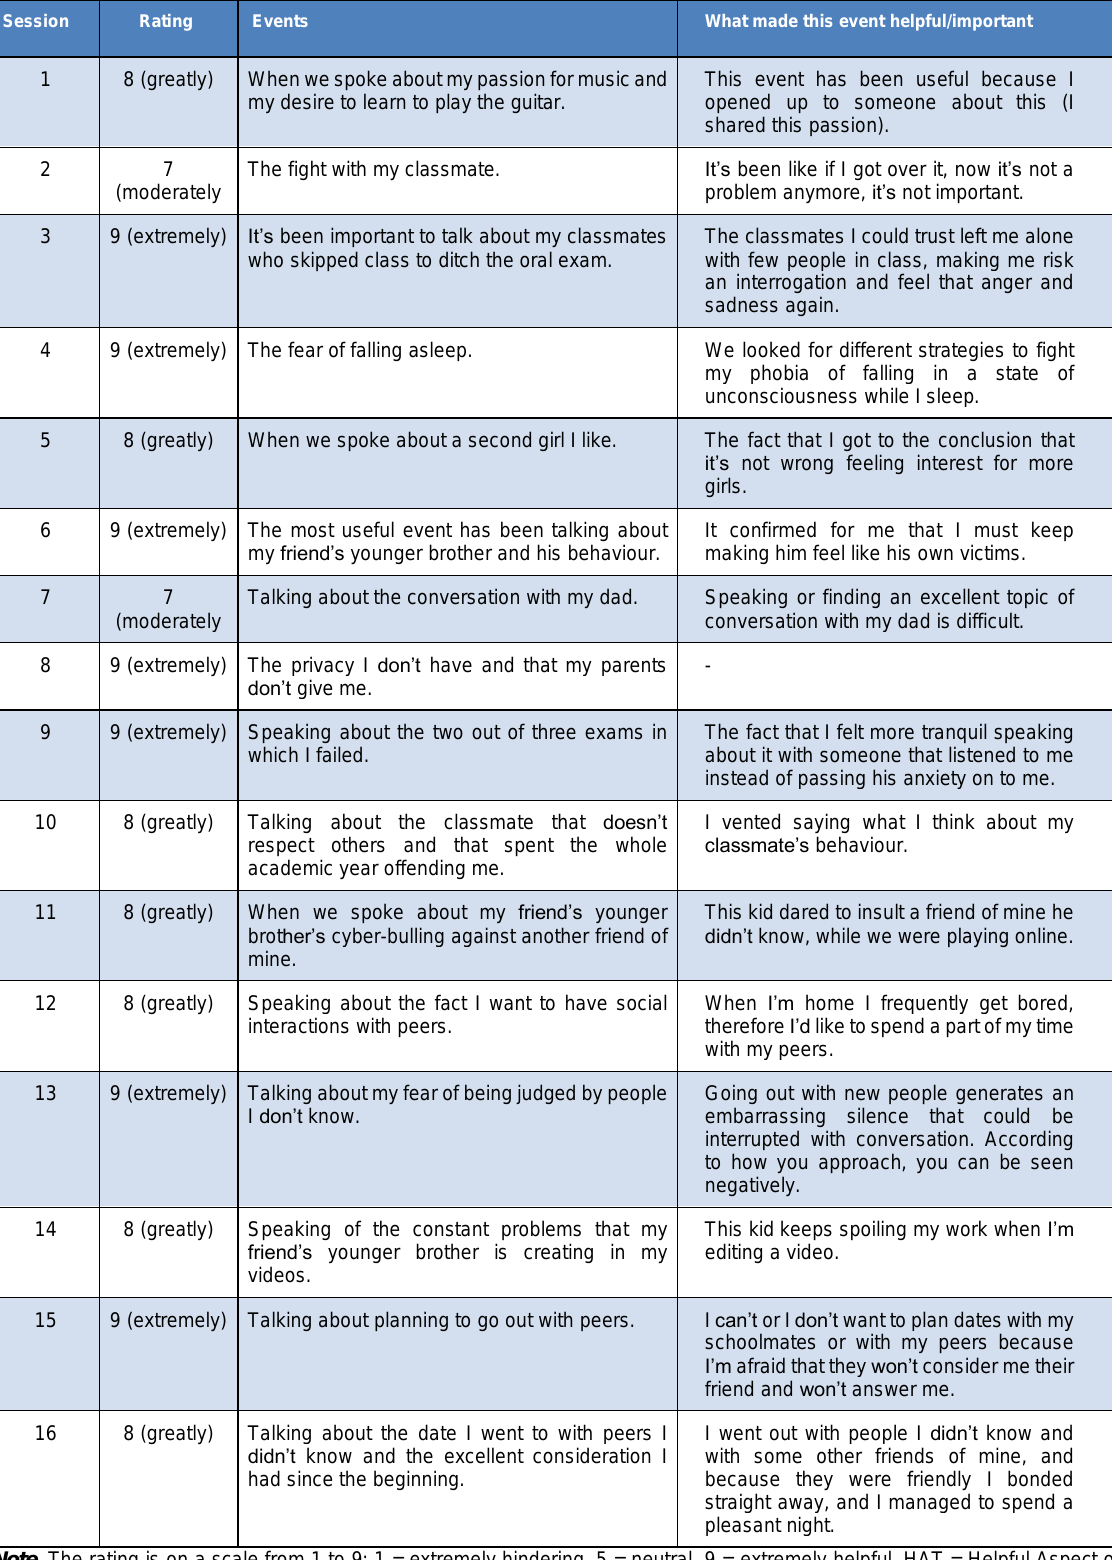
Table 4: Giovanni’s helpful aspect of therapy (HAT